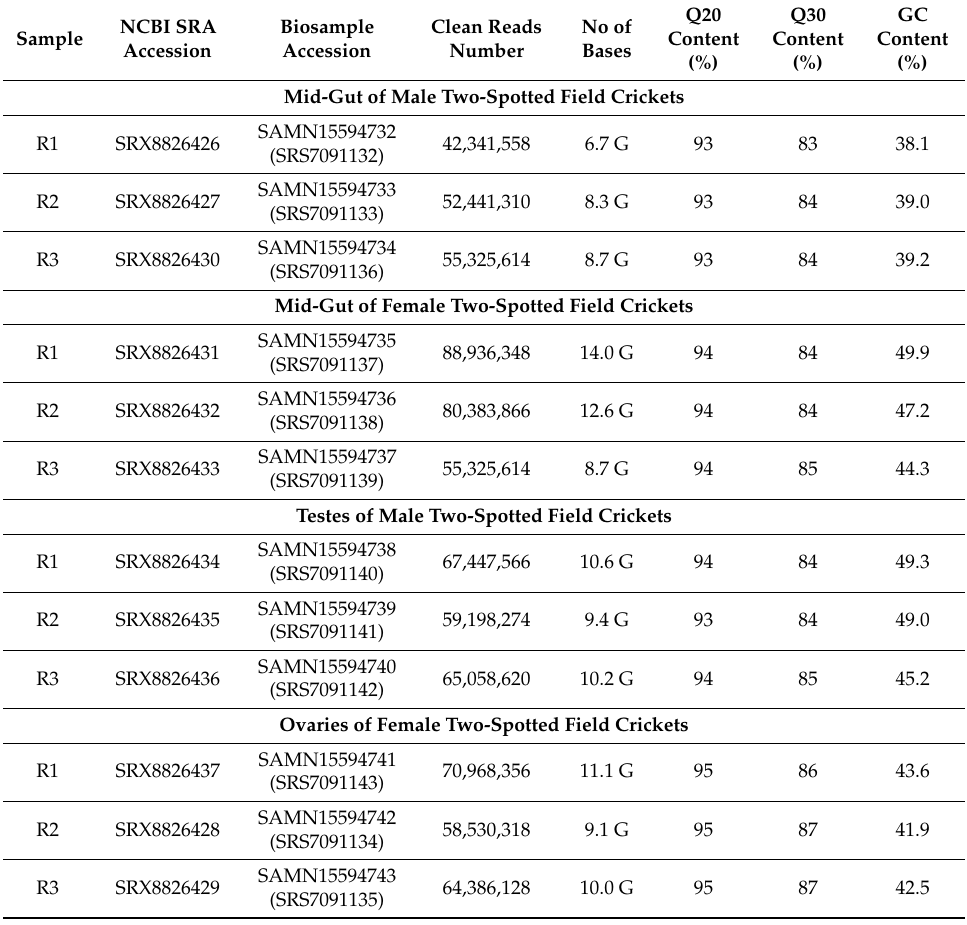
Table 1. Summary of the Illumina Platform RNA-Seq Metrics for two-spotted field crickets. Sample